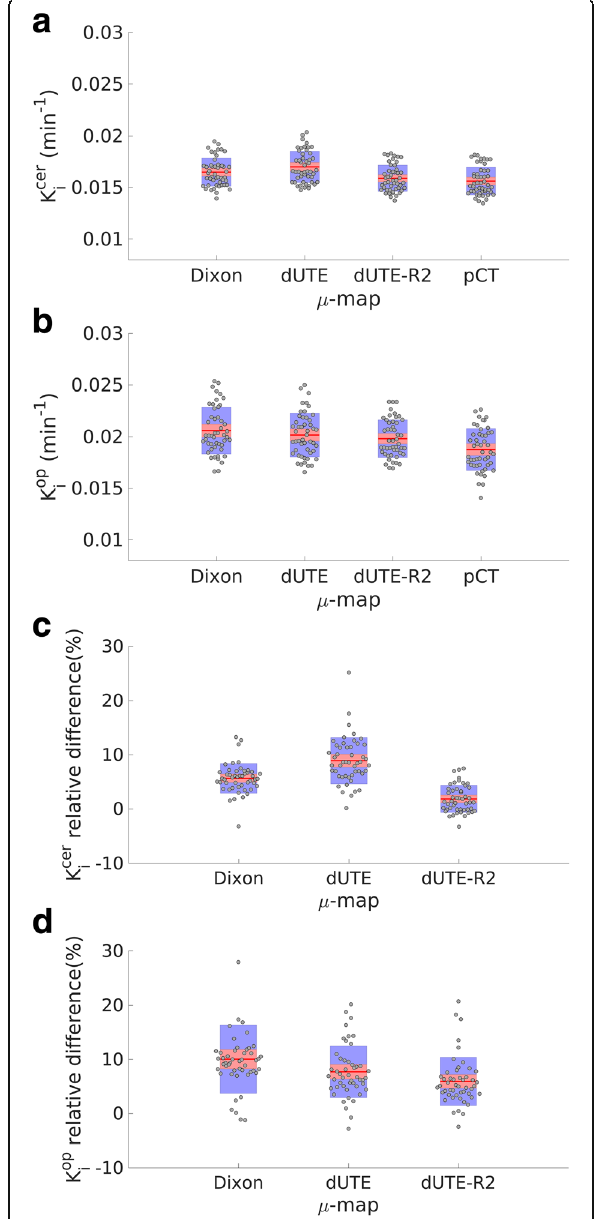
Fig. 6 K i cer ( a ) and K i op ( b ) measured in each subject in the region of the striatum obtained with reconstructed PET images calculated with the μ - map DXN , μ -map dUTE , μ -map dUTE − R2 , and pCT. The relative differences measured in each subject using the pCT as reference are shown in c and d for cerebellar cortex and occipital pole, respectively Table 5 Mean and standard deviation of the relative Table 3 Mean K i cer and standard deviation (cm − 1 ) μ -map μ -map μ -map DXN dUTE dUTE − R2 pCT